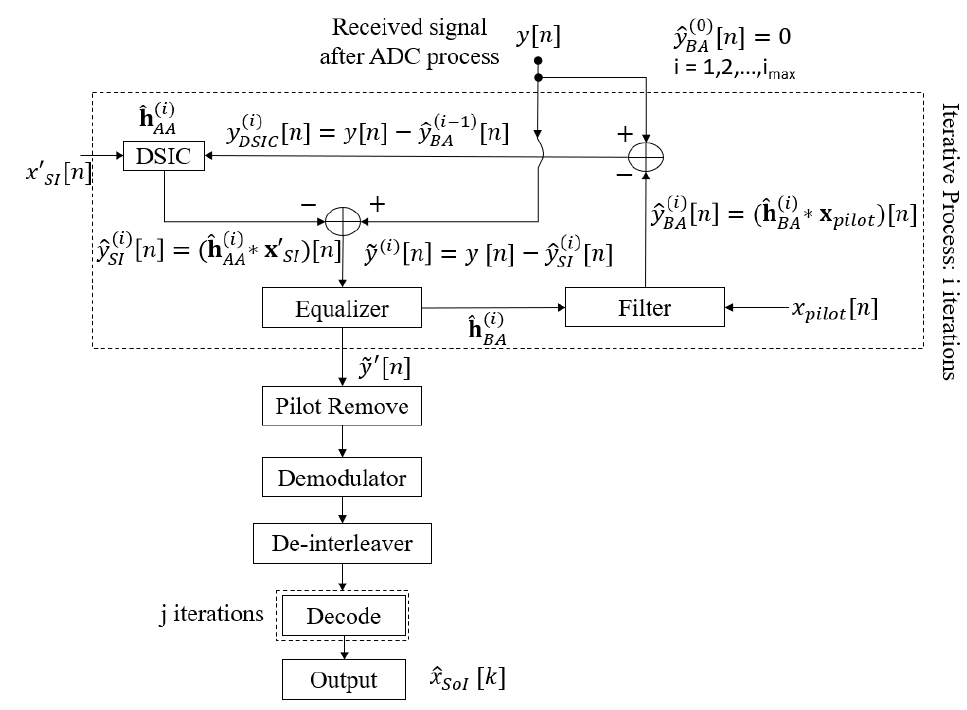
Figure 3. SISO FD transmission with the proposed JISB_DSICED3 process.